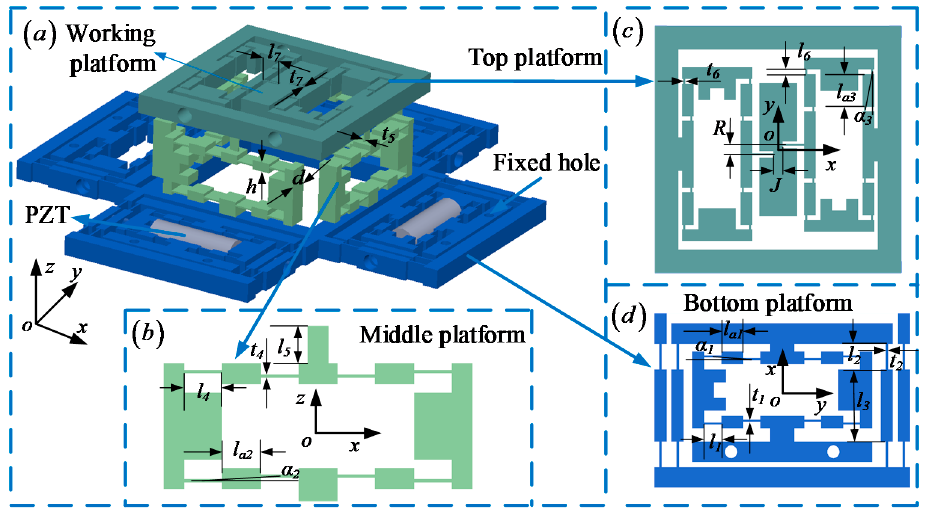
Figure 1. Schematic diagram of the six-degree-of-freedom (6-DOF) micro-positioner. ( a ) The overall structure of the micro-positioner, ( b ) the structure of the middle platfoem, ( c ) the structure of the top platfoem, ( d ) the structure of the bottom platfoem.